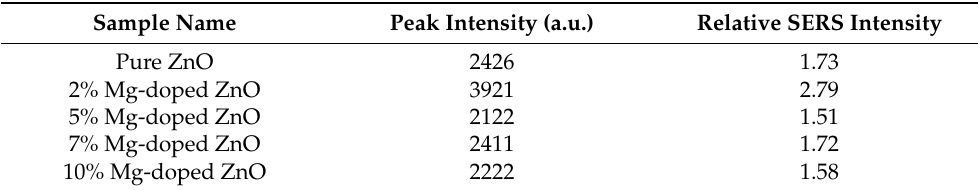
Figure A3. ( a ) Viability of MCF-7 cells treated with 3 µ g/mL ZnO and Mg-doped ZnO; ( b ) viability of MCF-7 cells treated with 6 µ g/mL ZnO and Mg-doped ZnO; ( c ) viability of MCF-7 cells treated with 12 µ g/mL ZnO and Mg-doped ZnO; ( d ) viability of MCF-7 cells treated with 50 µ g/mL ZnO and Mg-doped ZnO. Cell viability was measured after 24 h, 36 h, and 48 h by MTT assay. Data are represented as the mean of triplicate ± SEM. Table A1. A summary of the average Raman peak intensities and relative SERS enhancements of ZnO and Mg ‐ doped substrates at a 1341 cm − 1 wavelength.